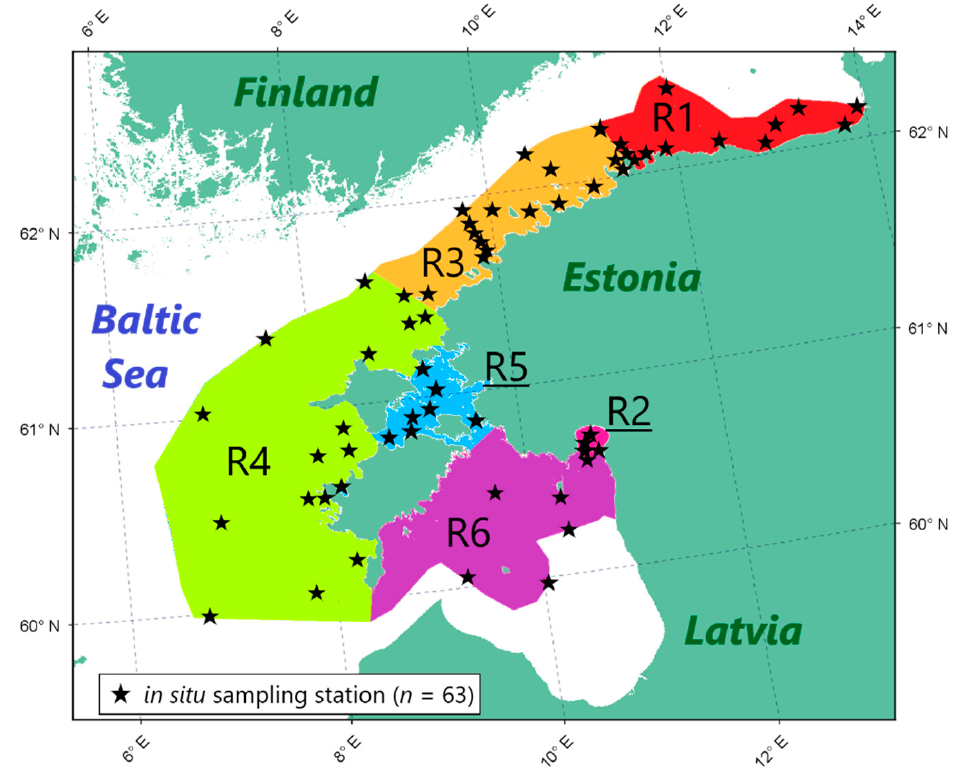
Figure 1. The different geographic regions in Estonian marine waters (R1–R6) with the locations of in situ sampling stations (black stars).